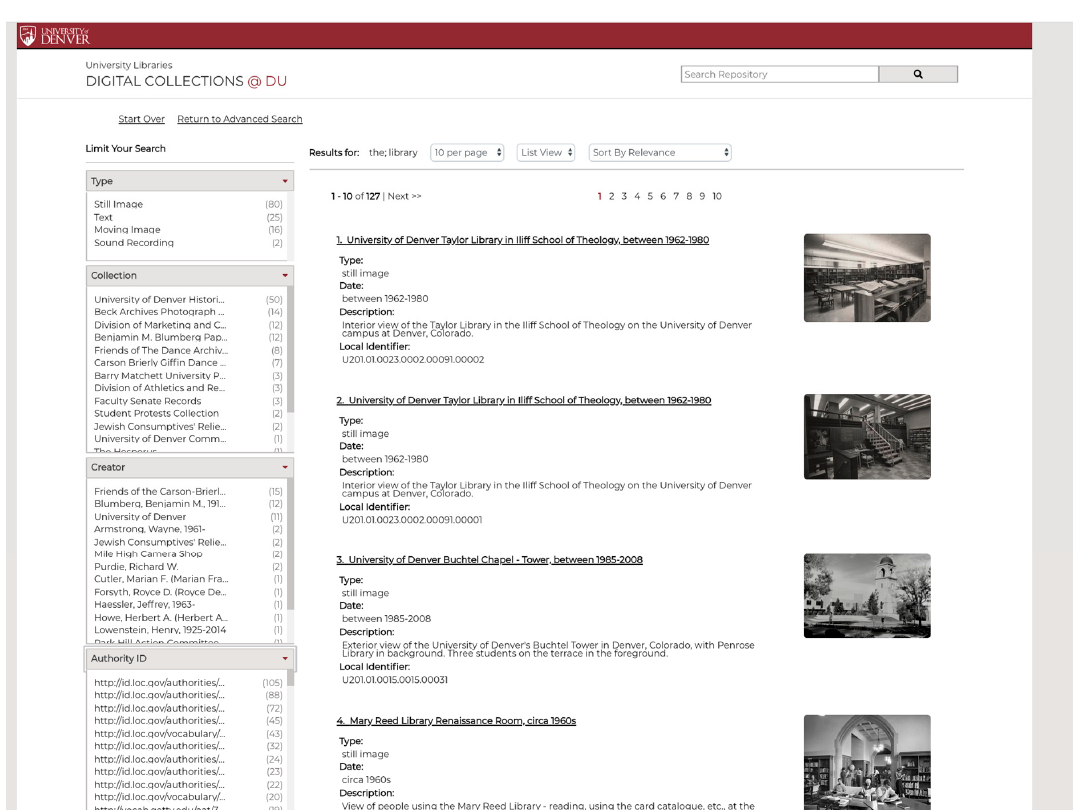
Figure A3. Search.